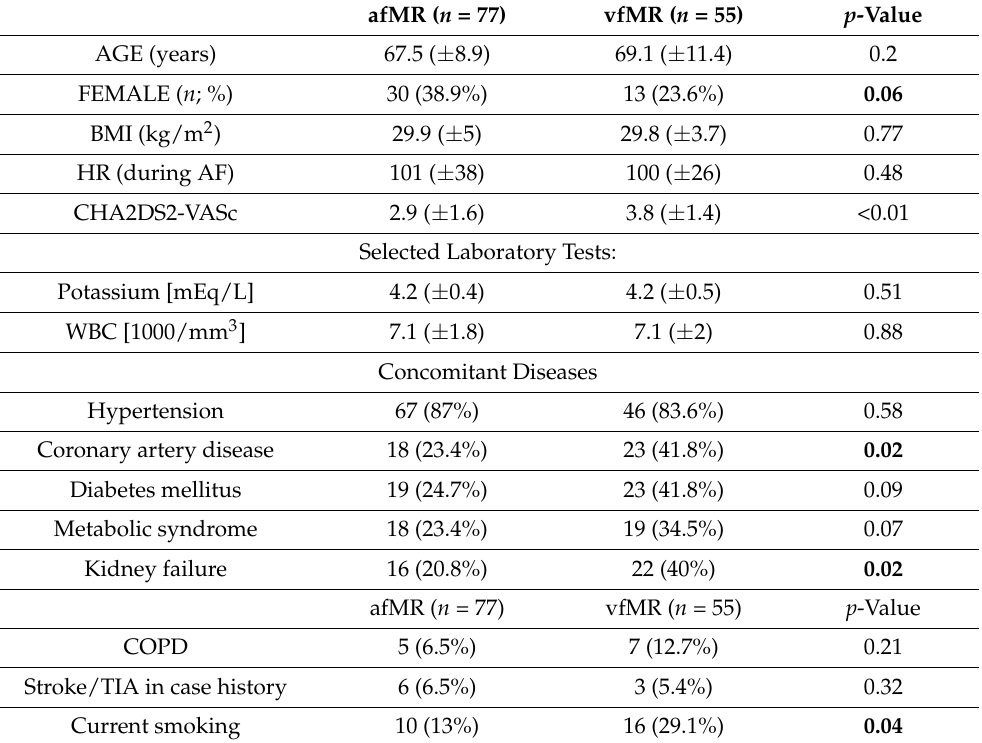
Table 2. Baseline characteristics, comorbidities and risk factors comparison between groups of patients with afMR and vfMR.